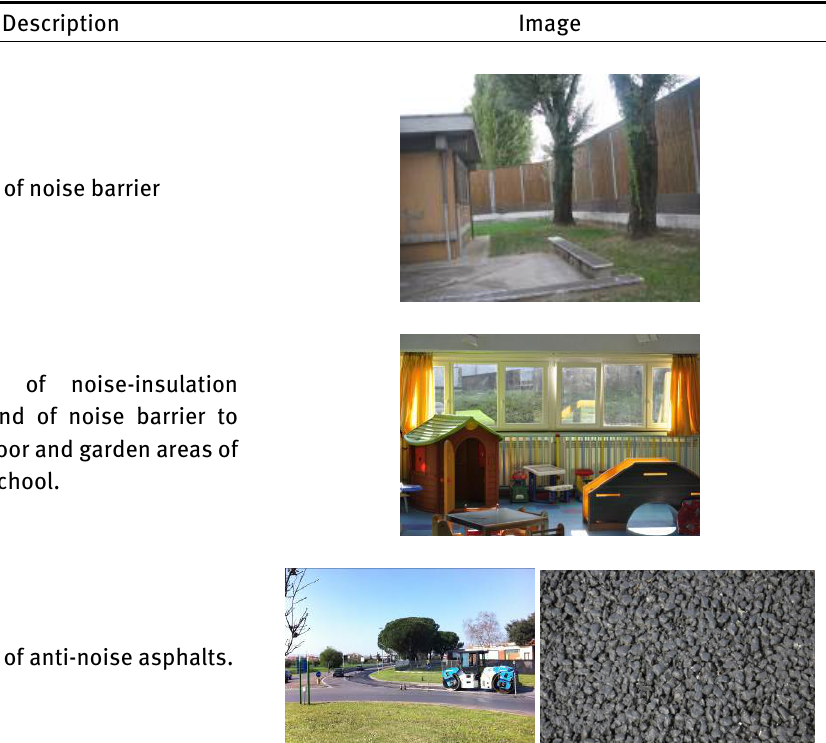
Table 8: Images of some anti-noise measures realized within the NADIA